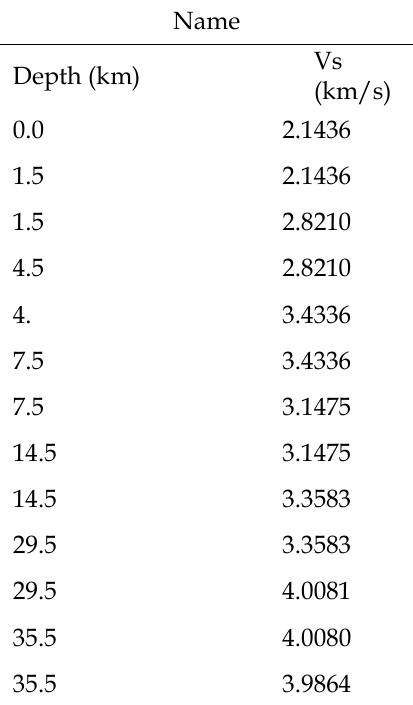
Table 2: Crustal Vs